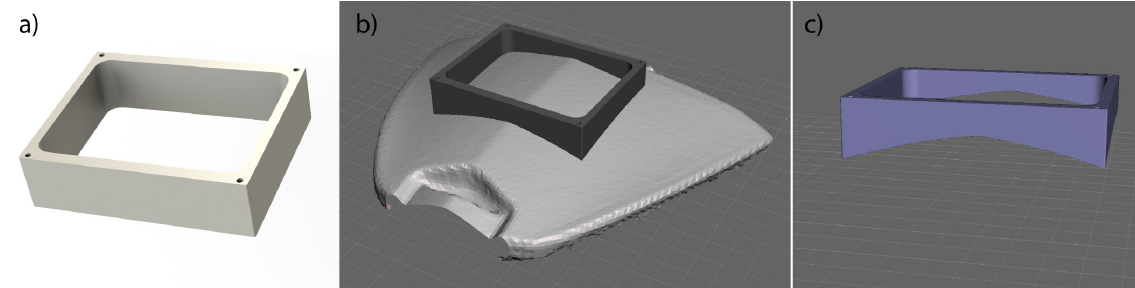
Figure 5: The adapter component template mesh (a), the utilization of the fairing mesh surface to trim the template mesh (b), and the final edited part prior to toolpath computation (c).